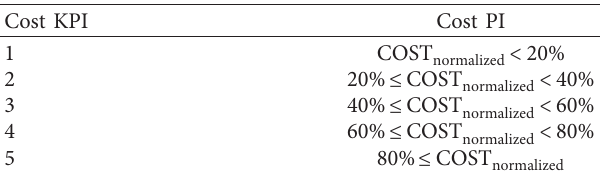
Table 5: Correlation between cost KPI qualitative scale and cost PI quantitative